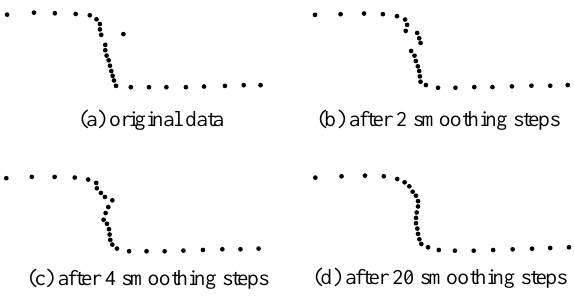
Figure 6. Smoothing of scanline by using Taubin